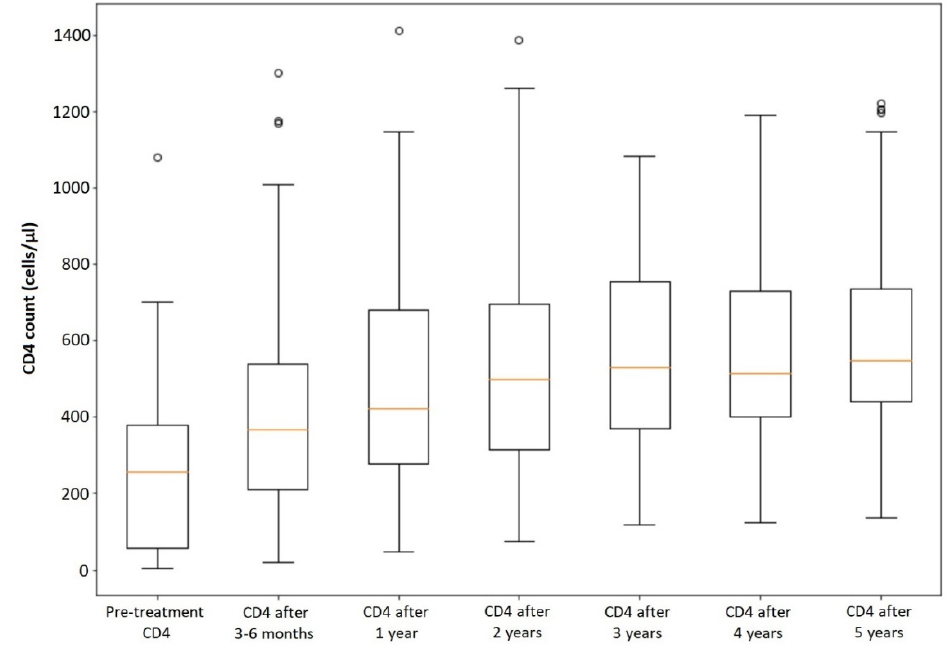
Figure 1. CD4 count recovery among all patients. The hollow circle stands for the outlier.